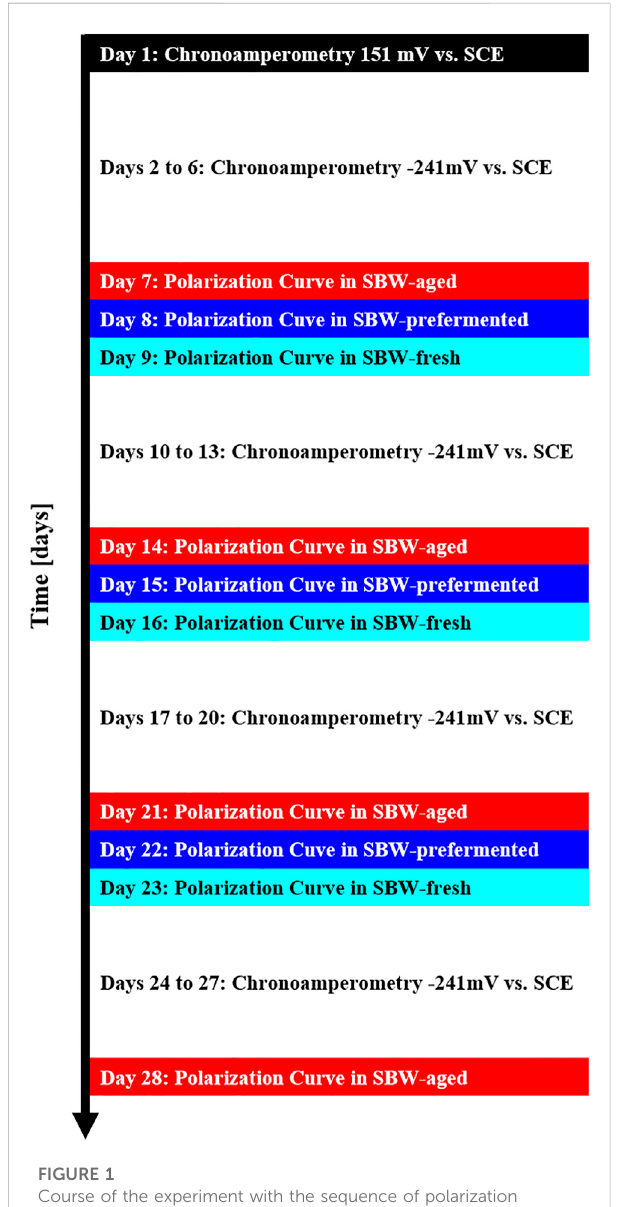
Course of the experiment with the sequence of polarization experiments done on the bioanodes. Chronoamperometric measurements are interrupted for polarization curve studies carried out in various media from − 400 mV vs. SCE to 0 mV vs. SCE in 50 mV steps for 30 min, followed by cyclic voltammetries from − 600 mV vs. SCE to 100 mV vs. SCE at a scan rate of 5 mV · s -1